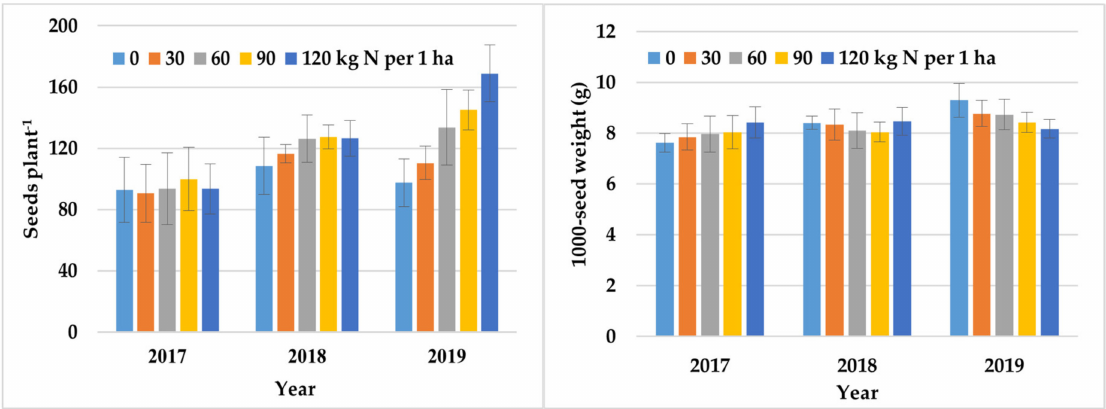
Figure 3. The e ff ect of N fertilization on the number of seeds plant − 1 and 1000-seed weight of crambe across growing seasons (2017–2019). Error bars represent the standard